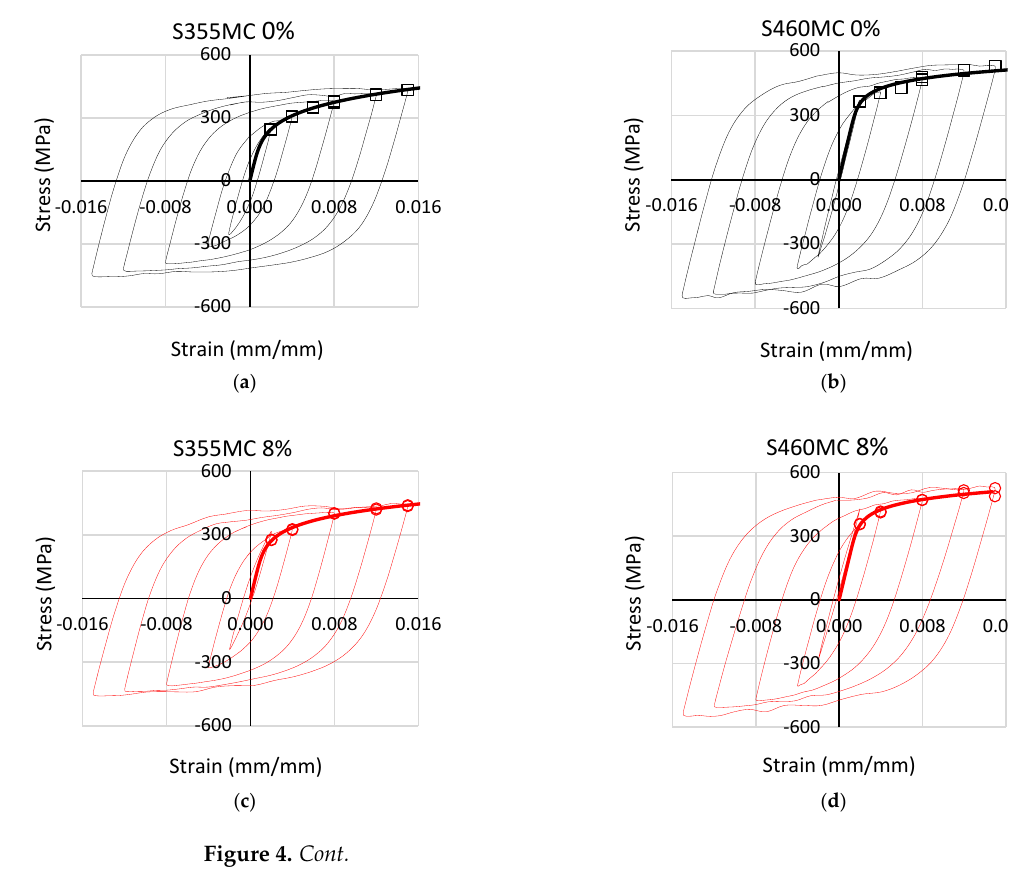
( f ) Figure 4. Stabilized stress – strain hysteresis loops of ( a , c , e ) S355MC and ( b , d , f ) S460MC steel for different pre-strain